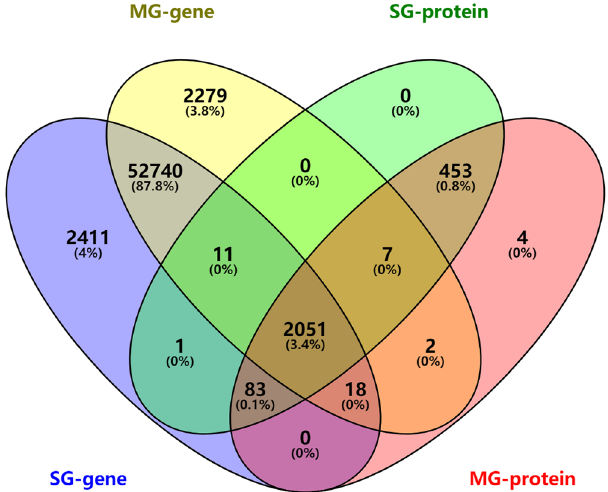
Figure 2. Venn diagram of transcriptome and proteome between NIL-723 and NIL-1010. The numbers in parentheses showed percentages concerning the total up-regulated and down-regulated. SG-gene represents genes of NIL-723, MG-gene represents genes of NIL-1010, SG-protein represents proteins of NIL-723, MG-protein represents proteins of NIL-1010. Veen diagram was generated usingInteractiVenn (http:// www. inter activ enn.